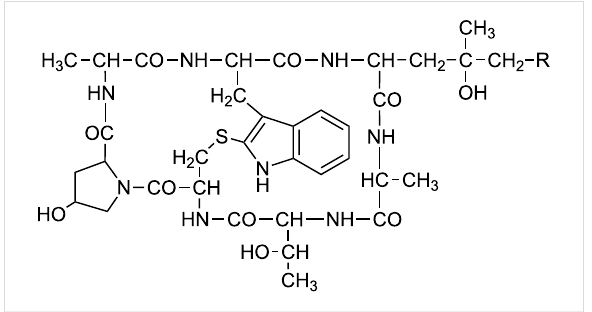
Figure 1: Chemical structure of phalloidin with the attachment site (R) used for conjugation to uptake-mediating moieties.